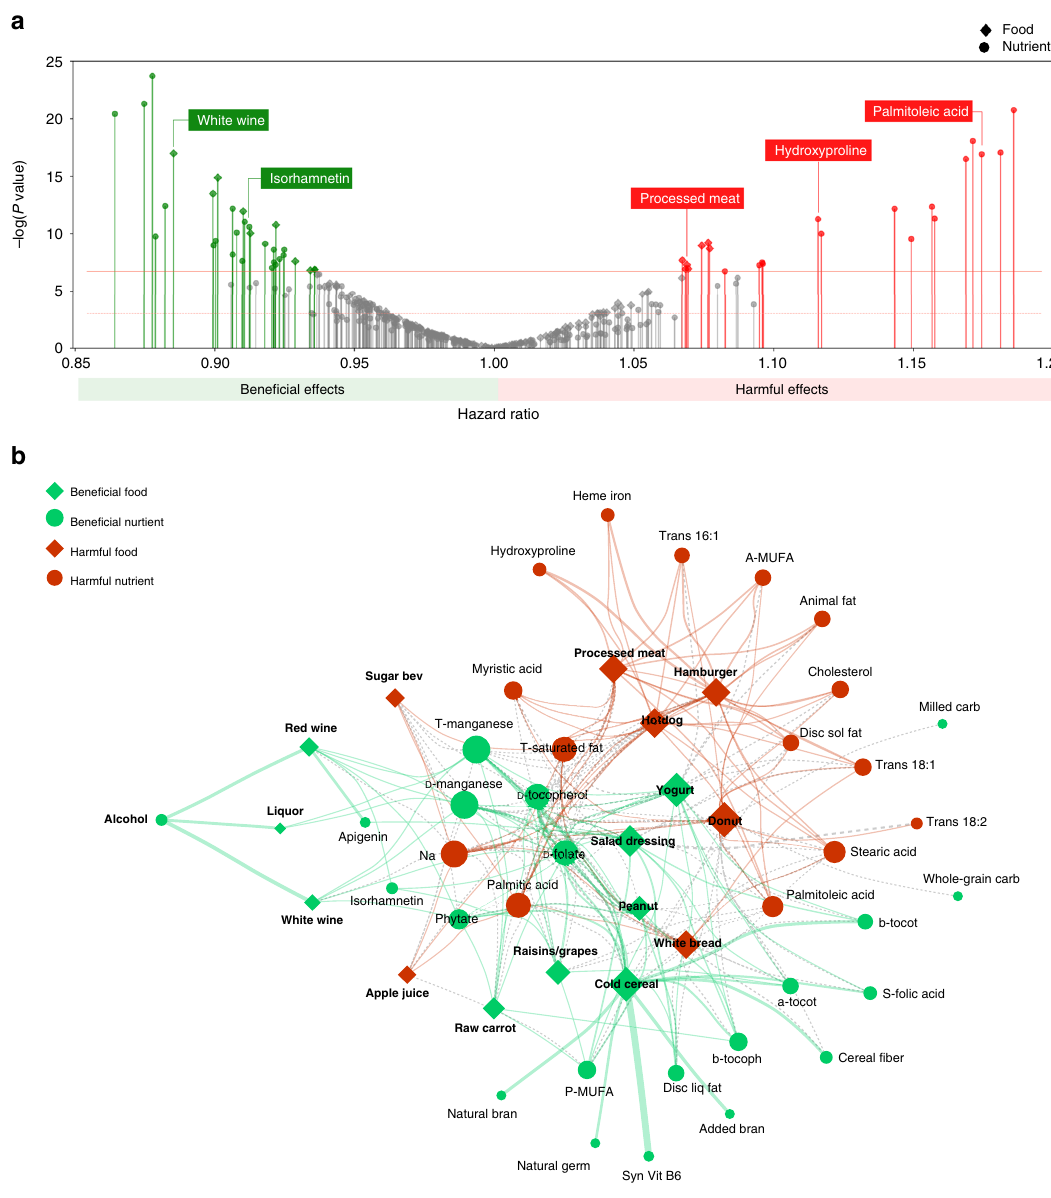
Fig. 3 P value Distribution of Dietary Factors and the Bi-partite Food-Nutirent Network. a P values are associated with two-sided Wald tests. The Y axis indicates the negative logarithm of the P value of each exposure. The dotted red horizontal line marks the level of 0.05 P value threshold and the solid red line demonstrates the level of 0.00117 P value threshold associated with the level of 0.05 FDR. Signi fi cant foods (diamonds) and nutrients (circles) with a negative association (HR < 1) are highlighted in green and exposures with a positive association (HR > 1) are shown in red. Source data are provided in Source Data - Figure 3-a.xlsx. b Bi-partite food-nutrient network, where negatively associated exposures are shown in green and positively associated exposures are shown in red. Different shapes are used to differentiate between foods (diamonds) and nutrients (circles). The node size is proportional to the absolute value of the estimated effect size. The link thickness is proportional to the amount of each nutrient ’ s composition in food. Source data are provided in Source Data - Figs. 3-b and